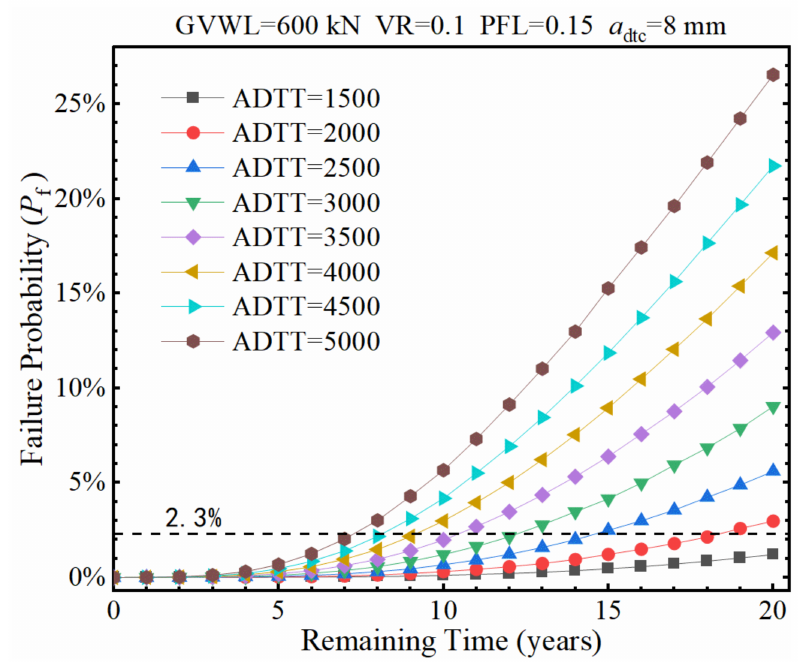
Figure 17. Failure probability of the fatigue detail under various